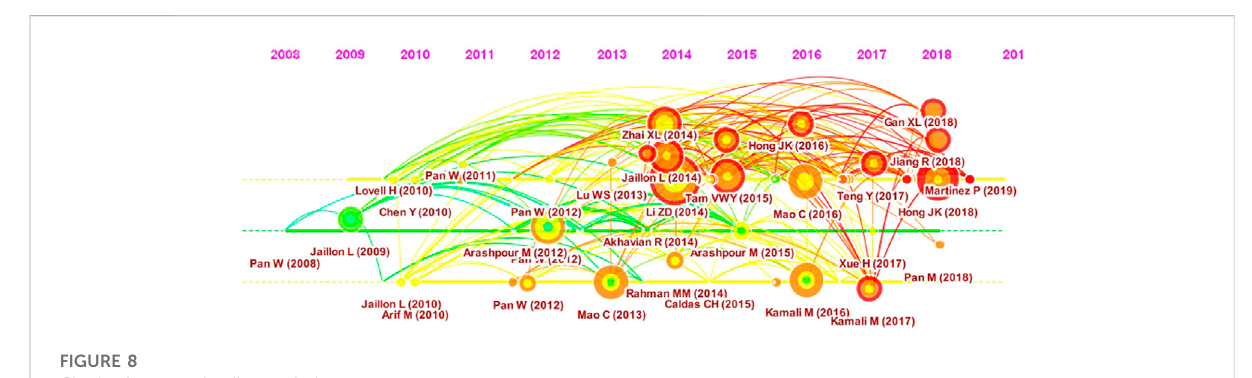
FIGURE 8 Cited references timeline